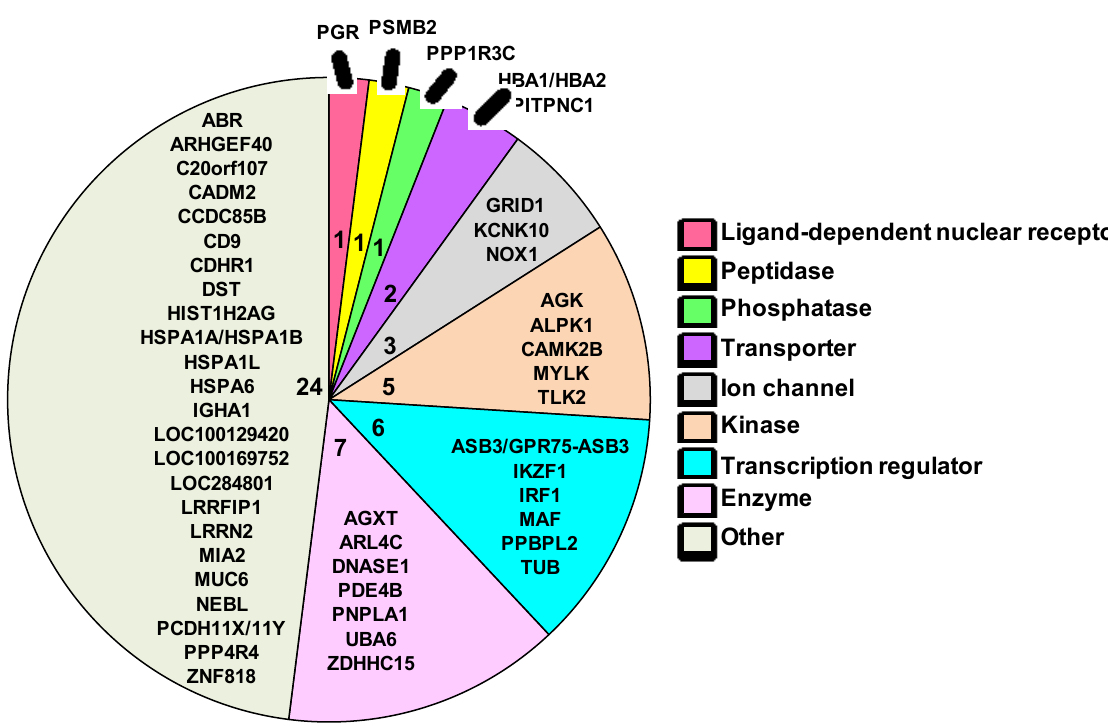
Figure 6. Pie chart of 50 shared biomarkers. Each sector of the pie represents the number of genes associated with each function. The symbols and number of genes are also provided for each function. Genes were filtered for an absolute value log value of p ≤